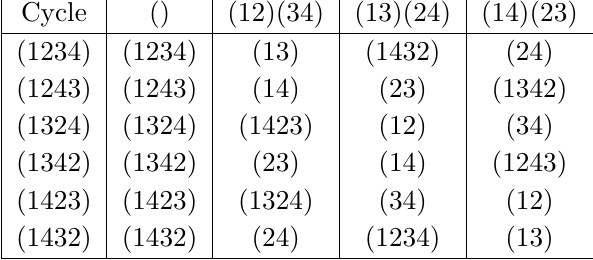
Table 7 . Left multiplication of fV